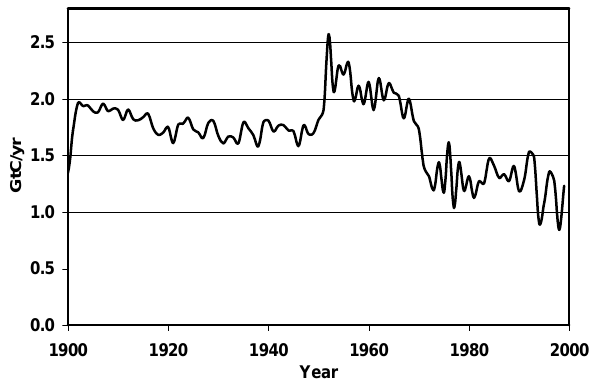
Figure 2. ISAM estimated annual global mean emissions from land use change (GtC/year) Fig. 2. ISAM estimated annual global mean emissions from land for the period 1900-2000. use change (GtC/year) for the period 1900–2000.